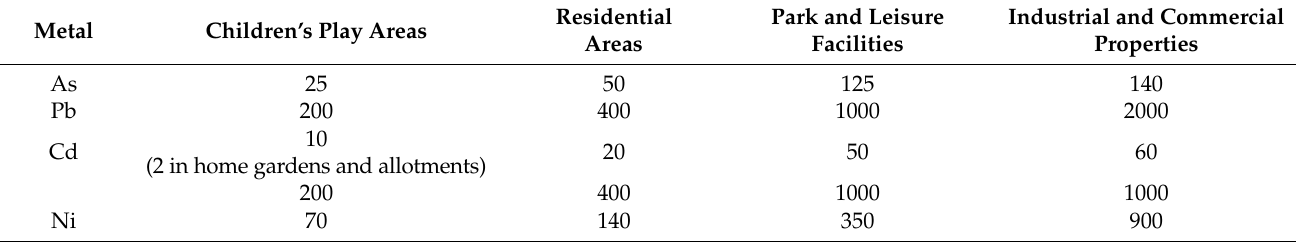
Table 3. Test values according to § 8 paragraph 1 sentence 2 no. 1 of the Federal Soil Protection Act [25] for the direct uptake of pollutants on children’s playgrounds, in residential areas, parks and recreational facilities, and industrial and commercial sites (in mg kg − 1 dry matter, fine soil).